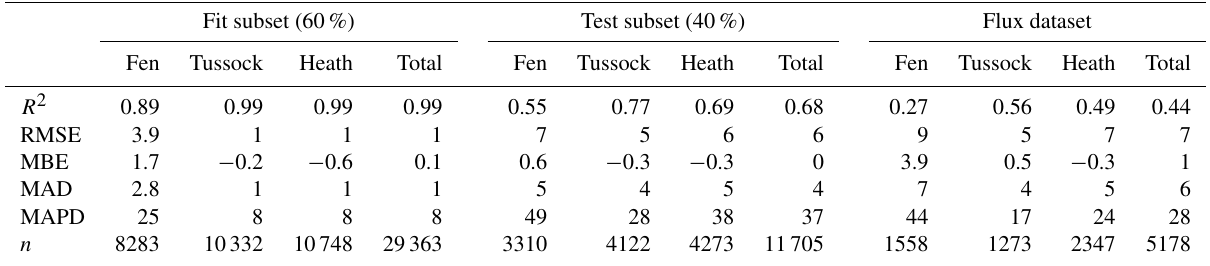
Table 4. Accuracy statistic for the new c TG approach for the fit and the test. RMSE, MBE and MAD are in Wm − 2 , MAPD is in % and n is the number of half-hour